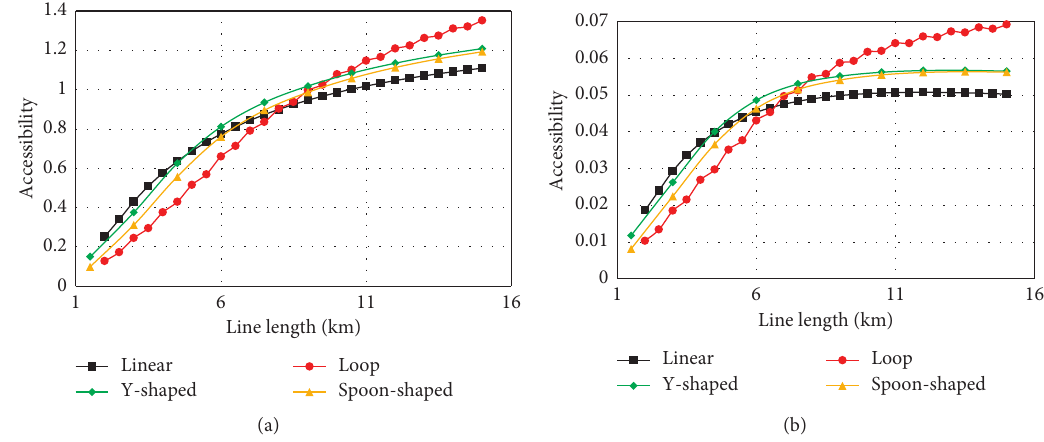
Figure 4: Comparison of accessibility of feeder lines with different shapes: (a) β � 1 . 1 and (b) β � 1 . 5.